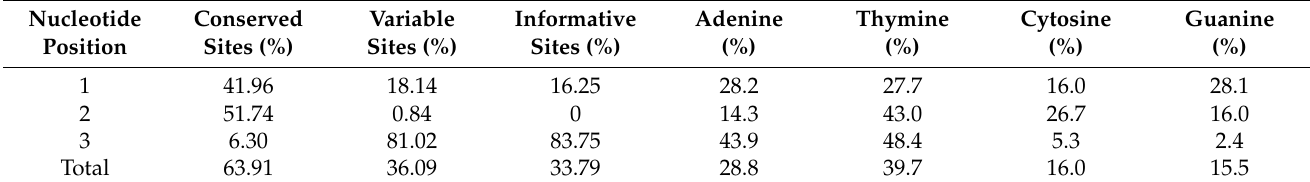
Table 1. Variable and informative sites, and average nucleotide composition in the aligned COI gene